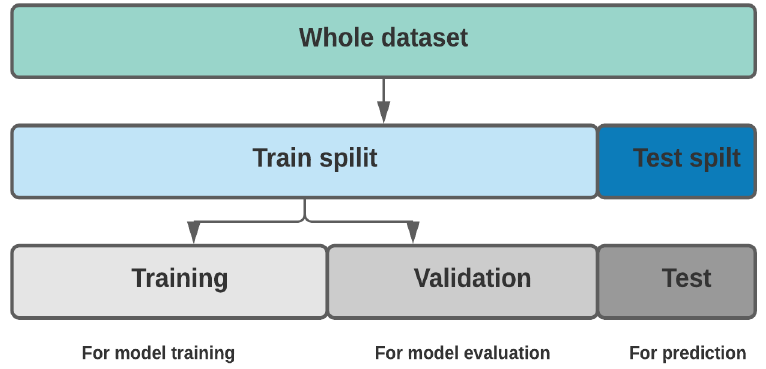
Figure 5. Schematic representation of the data splitting stage.